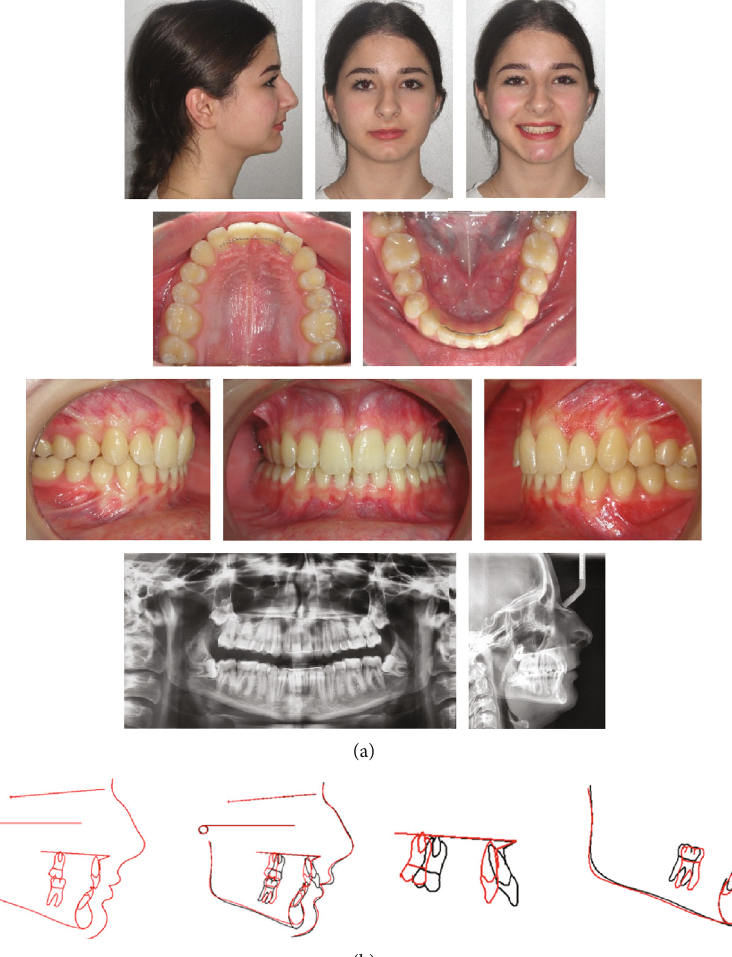
Figure 13: Case 2. (a) Patient after 24 months of treatment. (b) Superimposition of pretreatment (black) and posttreatment (red) cephalometric